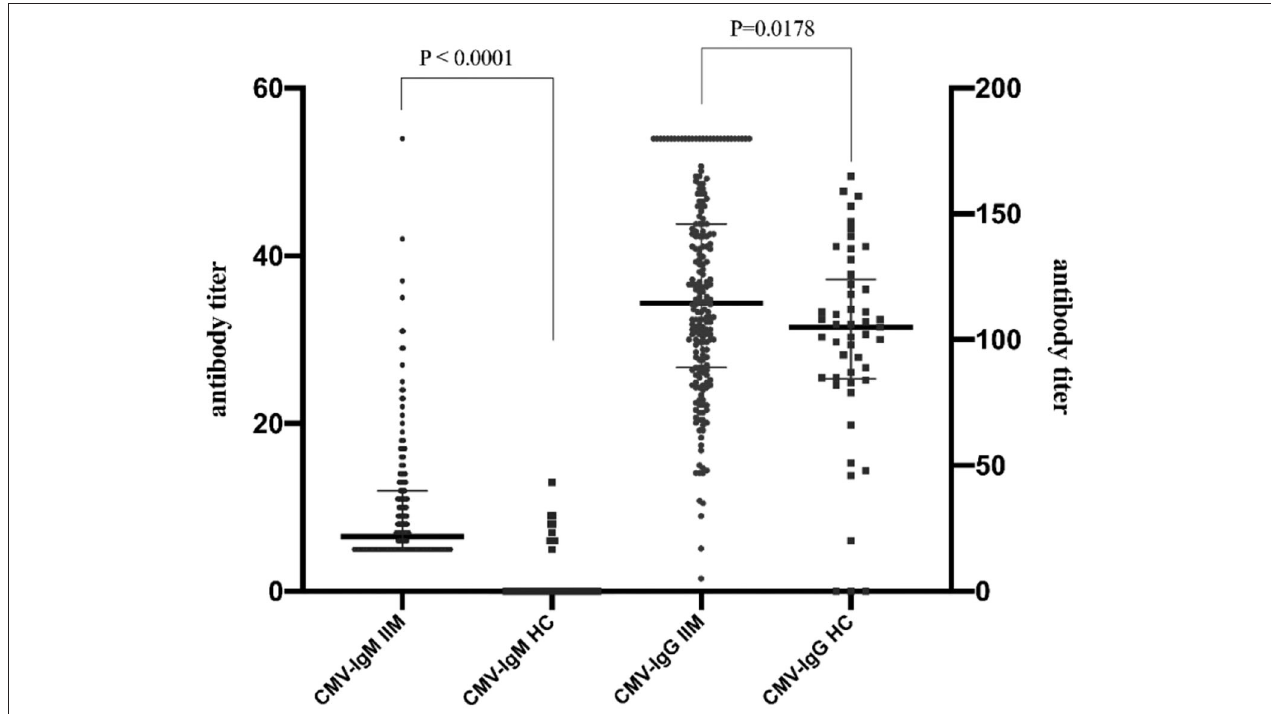
FIGURE 1 | Prevalence of anti-CMV-specific antibodies in healthy controls and IIM. Higher levels of IgG and IgM antibodies against CMV were detected in IIM patients than in healthy controls ( p < 0.05). Levels of CMV-IgM and CMV-IgG in IIM patients were significantly increased in healthy individuals compared with IIM patients